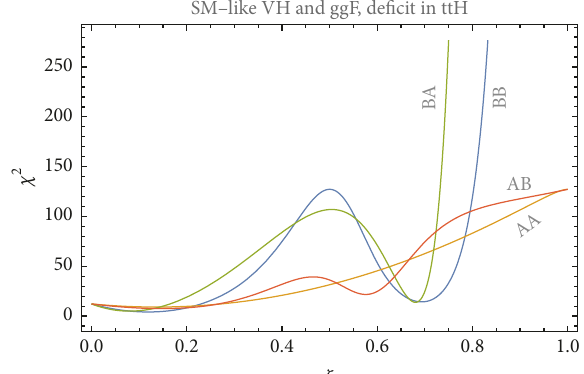
Figure 2: 𝜒(𝜉) 2 assuming a scenario where a deficit is found in 𝑡𝑡𝐻 production channels, while other channels remain consistent with the SM. The labels correspond to different hypothesis of 𝜅 퐴,퐵 퐹 for ( 𝜅 푡 , 𝜅 𝜅 = 𝜅 = 𝜅 퐵 푏 ). In this case, the choice 푡 푏 퐹 would be preferred by data. We assume a 20% uncertainty in these channels, except in 𝑔𝑔 → 𝐻 → 𝛾𝛾 where a 10% accuracy is assumed.